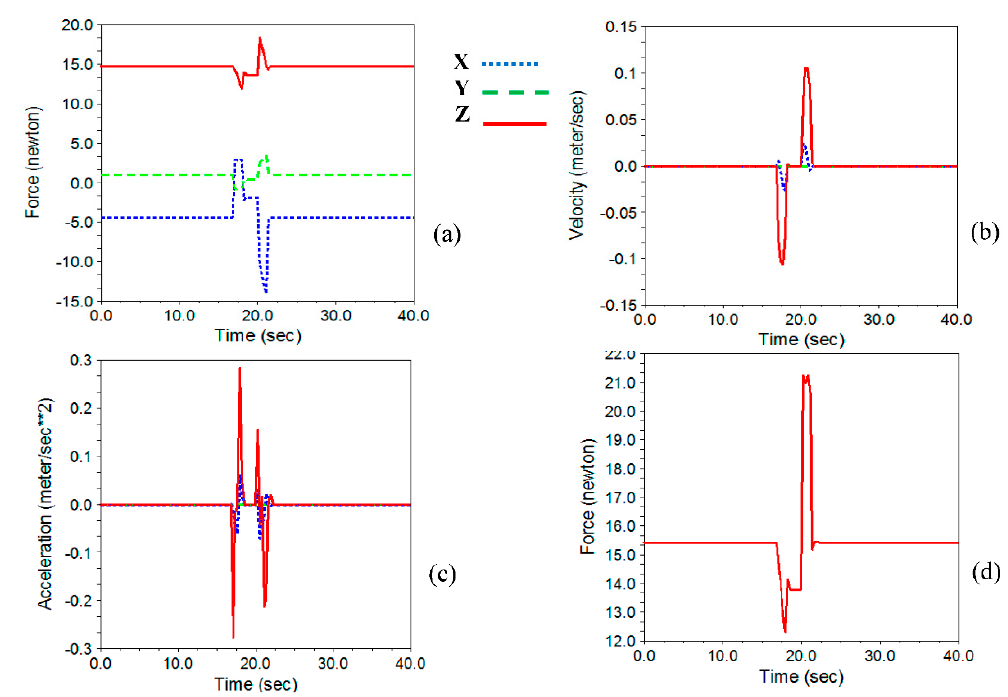
Figure 27. Results of ADAMS software simulation to determine the characteristics of the pneumatic jack of the cleaning subsystem (seven fish per minute). In this figure, ( a – d ) are force, velocity, acceleration, and resultant of the force in three direction respectively.